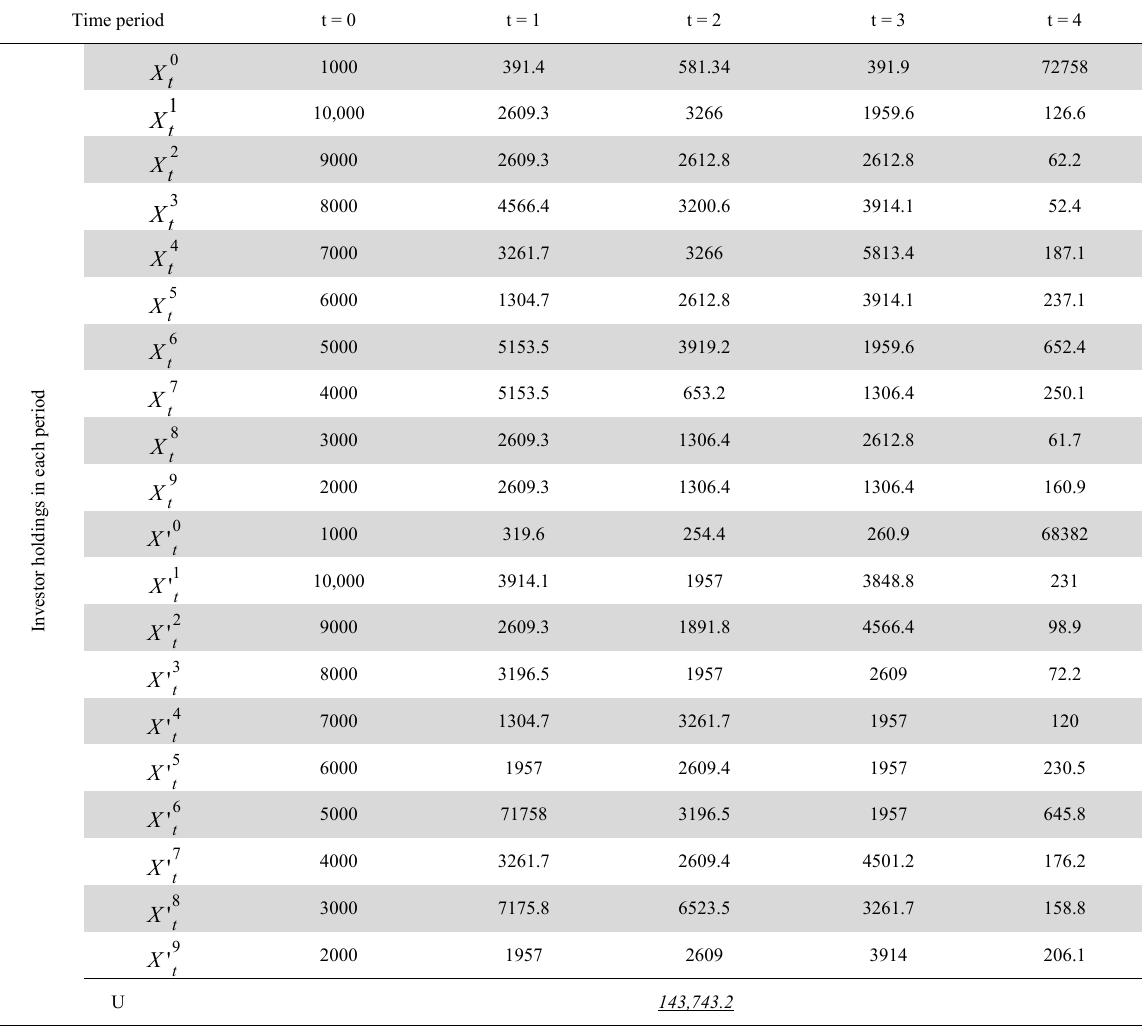
The results of the implementation of GA for the proposed